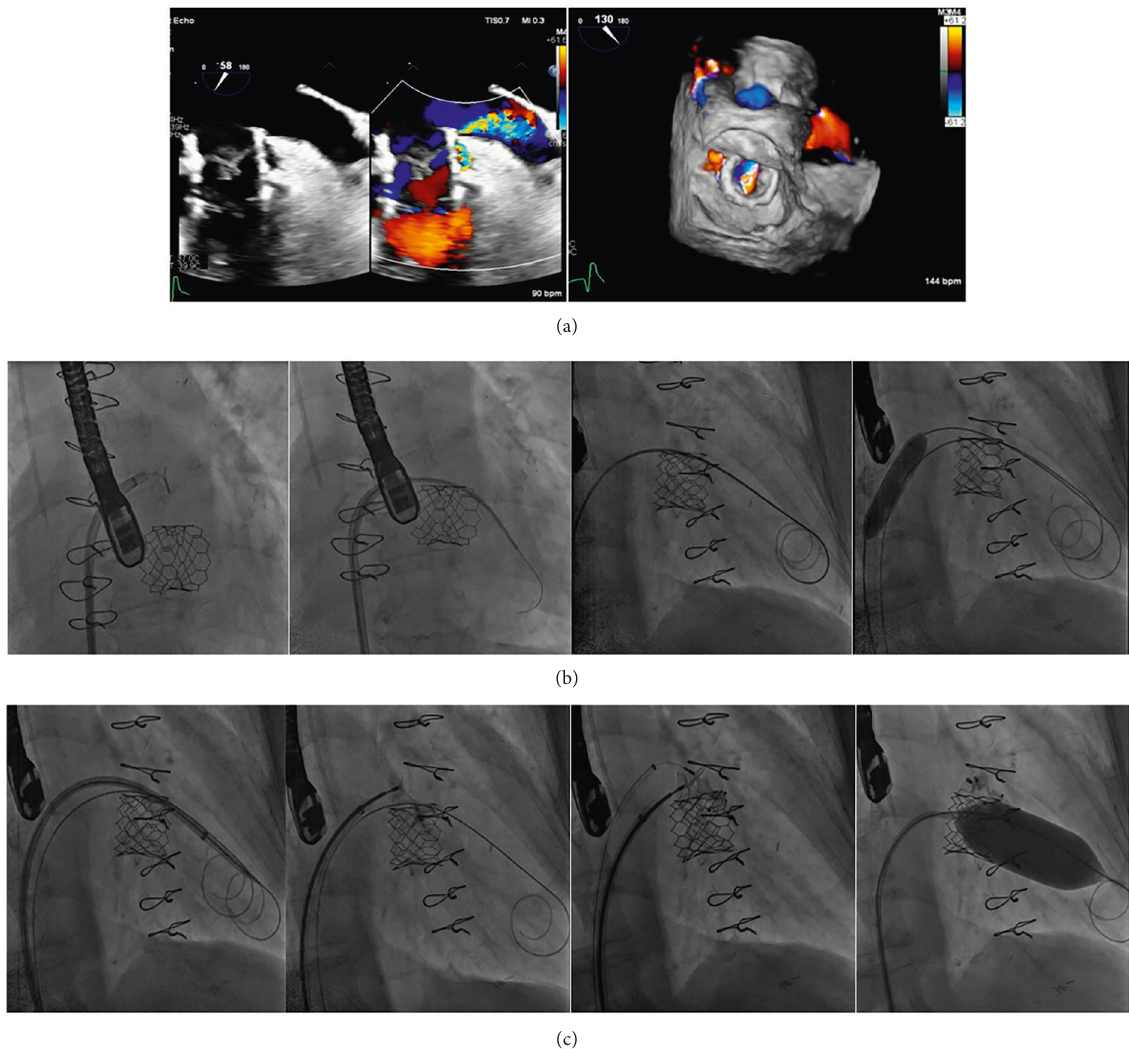
Figure 5: Transcatheter mitral valve in a St. Jude medical ring (TMViR) with a paravalvular ring leak. A 62-year-old female patient with a degenerated 27-mm MV St. Jude medical band post-MV repair and CABG with an associated AF. (a) TEE and color 3D-TEE 3 months post- TMViR with a SAPIEN-3 26mm valve with a moderate to severe lateral paravalvular leak at 9–10 o’clock. (b) Fluoroscopy shows transseptal puncture through an 8.5F-SL sheath, followed by the crossing of a 5F-MP catheter on a 0.035-inch curved Terumo guidewire through the paravalvular leak from the LA side to the LV side. The guidewire was exchanged for two 0.035-inch/260 extra-stiff Confida ™ guidewires, with balloon dilatation of the transseptal puncture using a 12mm balloon. (c) Fluoroscopy shows the deployment of an Amplatzer ™ muscular VSD 12mm device and an Amplatzer ™ vascular plug II 10mm device, with post-TMViR balloon dilatation with an Edwards balloon 25mm. The valve migrated and finally, the patient underwent surgical MV replacement. AF: atrial fibrillation; 3D: three-dimensional; LA: left atrium; LV: left ventricle; TMViR: transcatheter mitral valve-in-ring; TEE: transesophageal echocardiography; VSD: ventricular septal